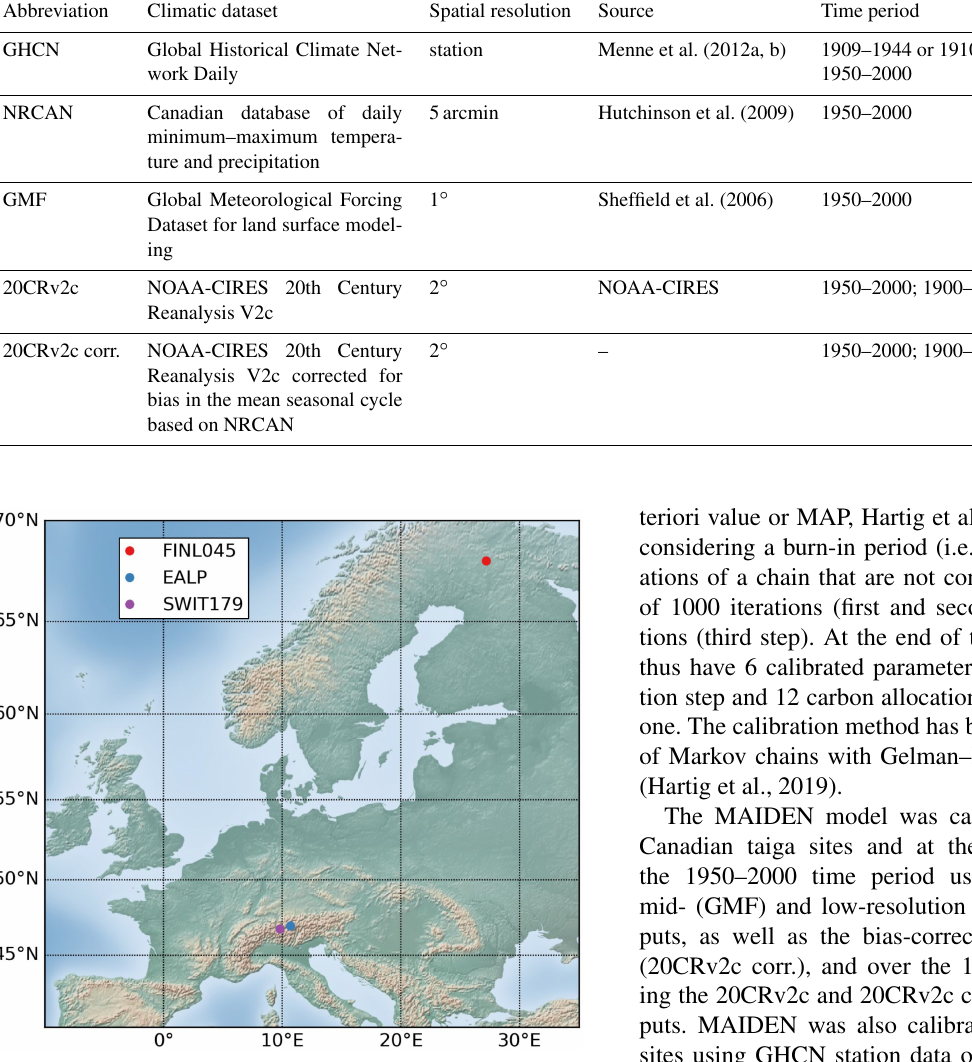
Figure 2. Location of three European sites with tree-ring width ob- servations used in this study. Background map from Hunter